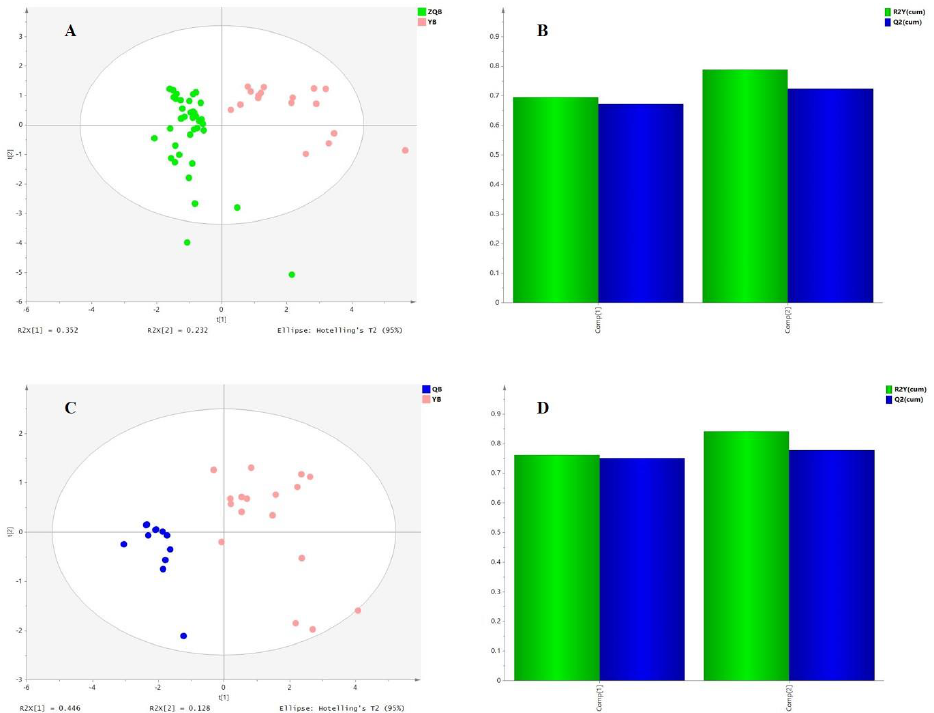
Figure 5. The PLS-DA of bulbus of FCB and FPB based on the content of nine alkaloids: score plot ( A , C ) and cumulated percentage variation explained by principal components ( B , D ).